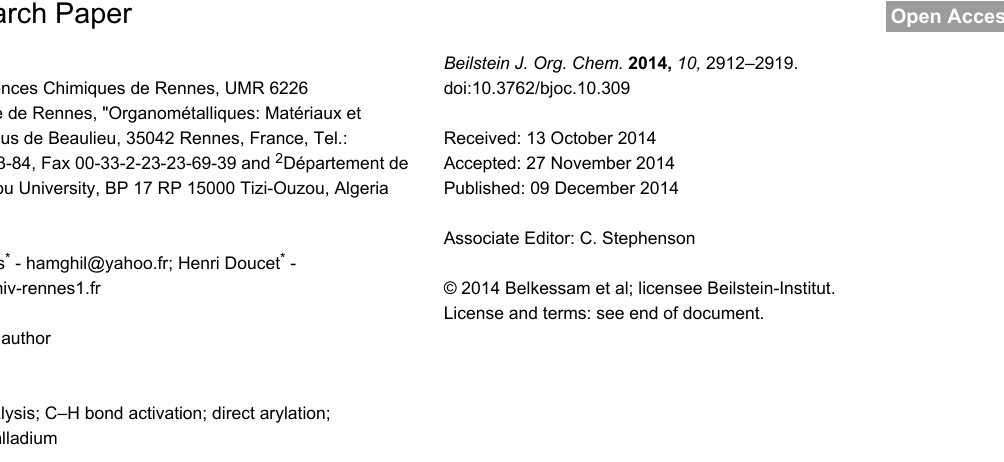
Figure 1: 2,2':5',2"-Terthiophene.